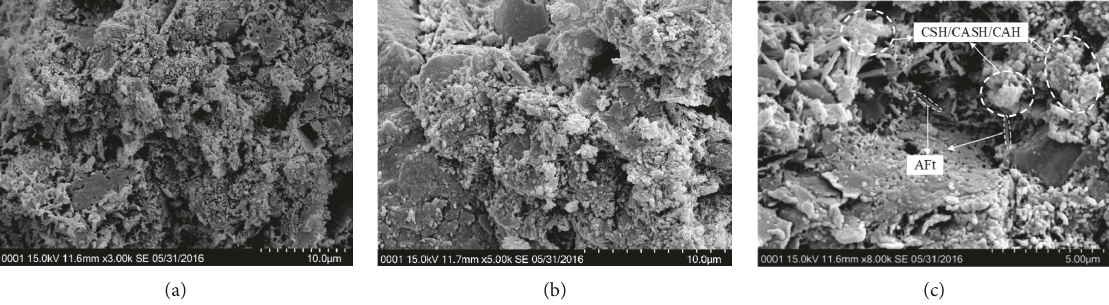
Figure 7: SEM photo of cement-treated JX clay mixture with 20% MK replacement. (a) 3000x; (b) 5000x; (c) 8000x.